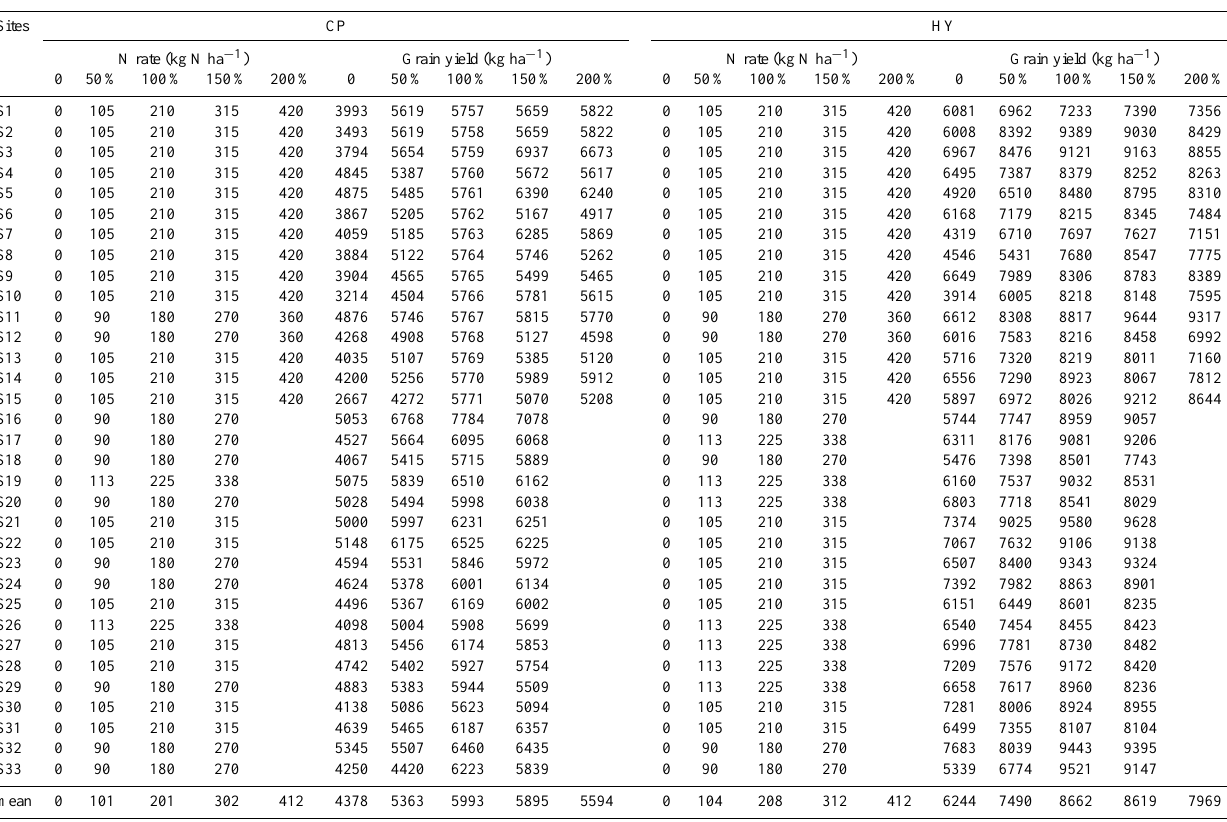
Table 1. N application rate and wheat grain yield for different N application rates and the two systems. N application rate including no N as